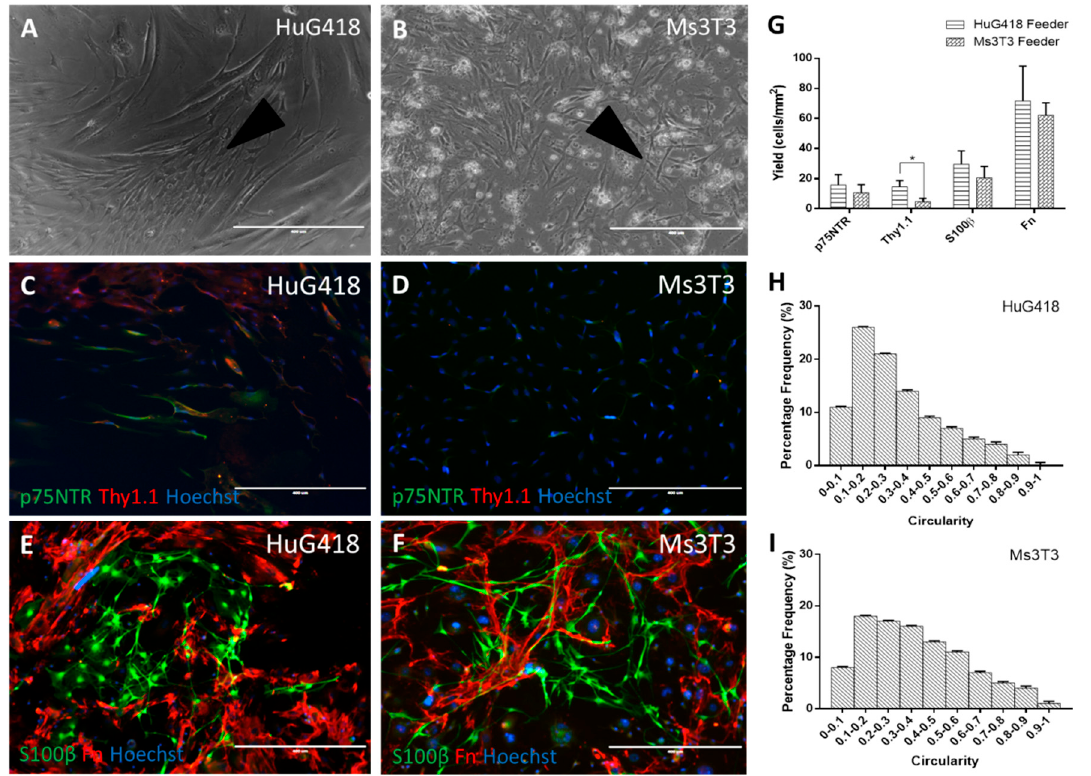
Figure 3. Cells were fixed after 14 days of culture and stained for OEC biomarkers p75NTR and S100 β and fibroblast biomarkers Thy1.1 and Fn ( A–D ). Positive cells were quantified in ImageJ and graphed as the yield of positive cells in the image area ( E–G ). Circularity was used as a measurement of morphology, and positive S100 β cells were analysed for their circularity ( H , I ). The scale bars represent 400 µ m. Data are the means ± SEM, n = 3.